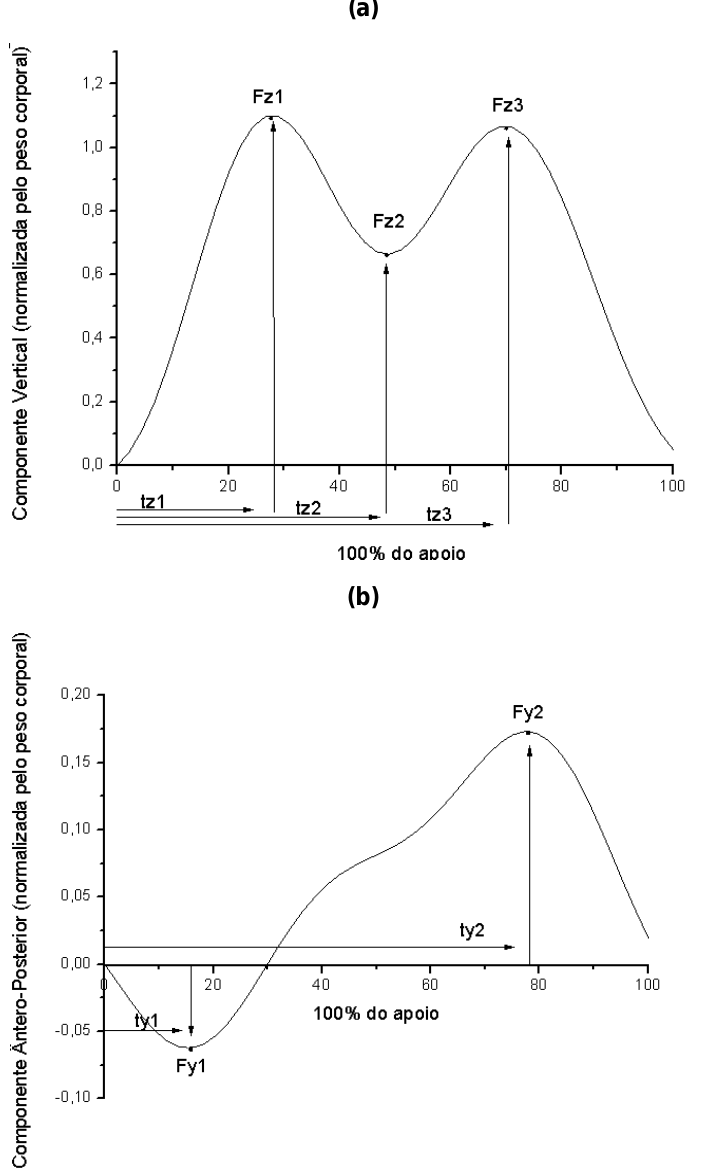
Figura 1. Gráficos selecionados das FRS das componentes vertical (a) e anteroposterior (b) de um